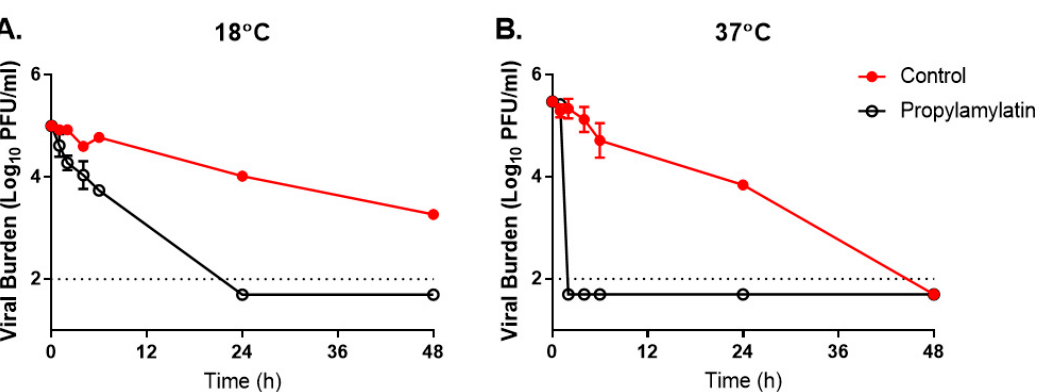
Figure 2. The effect of the Propylamylatin formula vapors on the infectivity of SARS-CoV-2. A suspension of 10 5 PFU of SARS-CoV-2 was exposed to the Propylamylatin formula vapors resulting from a 100 µL aliquot of the Propylamylatin formula and incubated at either ( A ) room temperature (18 °C) or ( B ) body temperature (37 °C). At various times post- Propylamylatin-formula exposure, viral suspensions were harvested, and viral burden was quantified by plaque assay in Vero E6 cells. Viral burden is reported as log 10 PFU/mL. Data points correspond to the geometric mean of two independent samples and error bars represent one standard deviation. The horizontal dashed line signifies the plaque assay limit of detection.